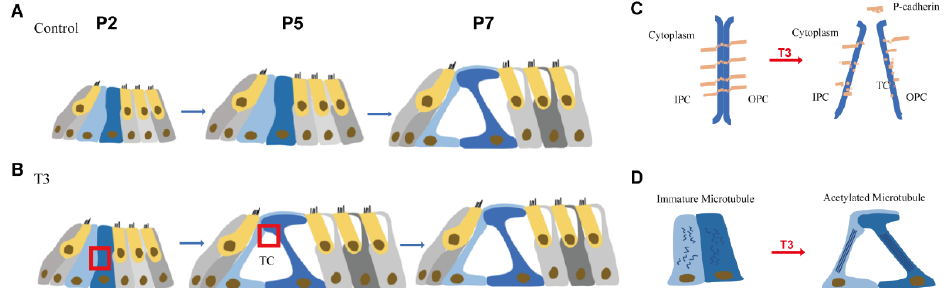
Figure 7. Pattern of T3 regulates the opening of the organ of Corti through modulating P-cadherin and acetylated microtubule. ( A , B ) Tunnel of Corti of control mice was opened duringP5 to P7, while T3 promote the opening of TC earlier on P5. ( C , D ) shows the detail of red frame in ( B ). ( C ) shows that T3 promoted the process of P-cadherin dissipated from the membrane of PCs. ( D ) shows that T3 increased the acetylated microtubule in PCs, as well as making the PCs longer and closer to the mature